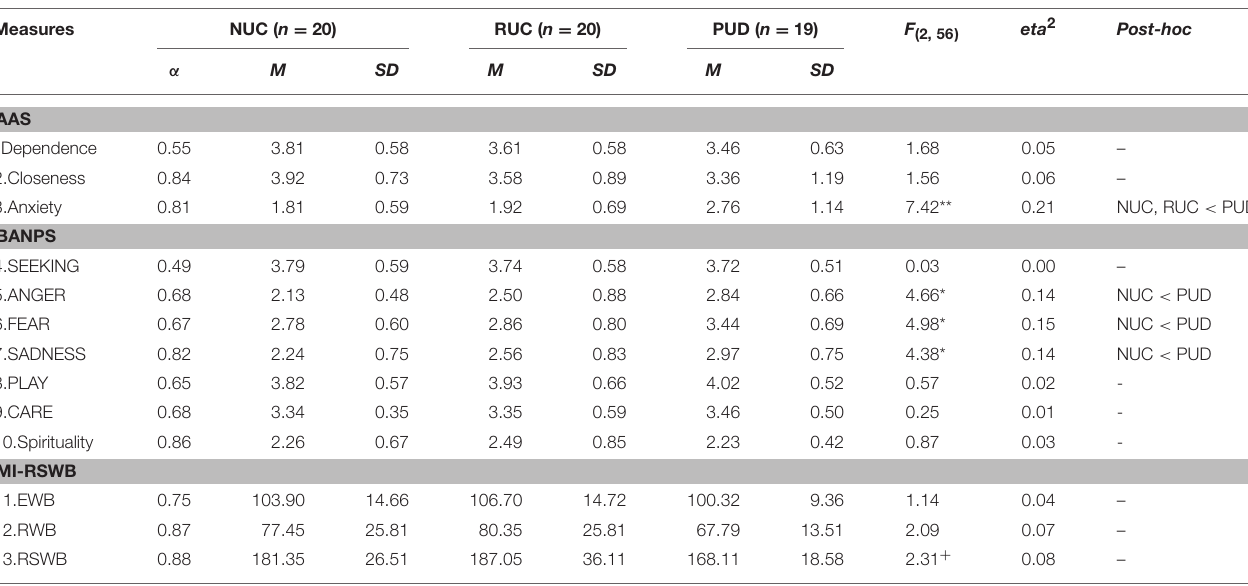
TABLE 2 | Group differences (ANOVA) in behavioral